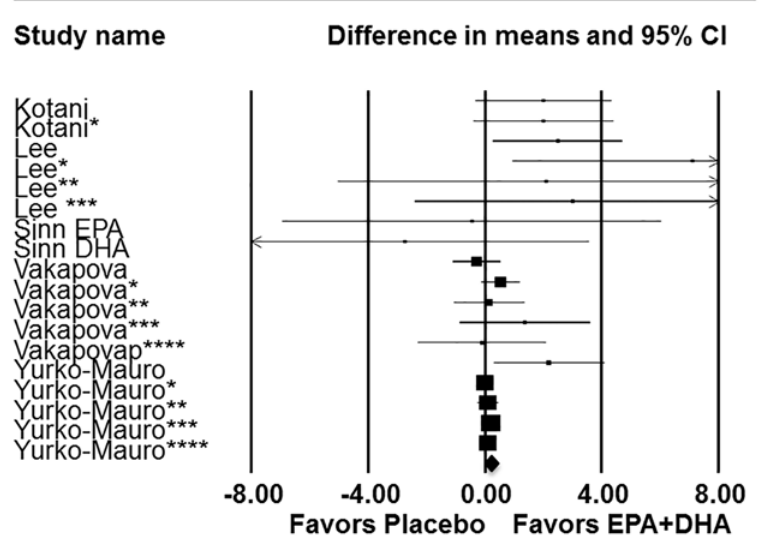
Fig 2. Forest plot with meta-analysis of episodic memory data. Episodic memory data from pertinent human intervention studies (n = 5) of DHA supplementation in adults with mild memory complaints. * Asterisks denote study included more than one test of episodic memory, results for each episodic memory test within a given study represented individually. Summary statistics are as follows z = 1.932 (p = 0.053); Hedge ’ s g z = 2.86 (p = 0.004).